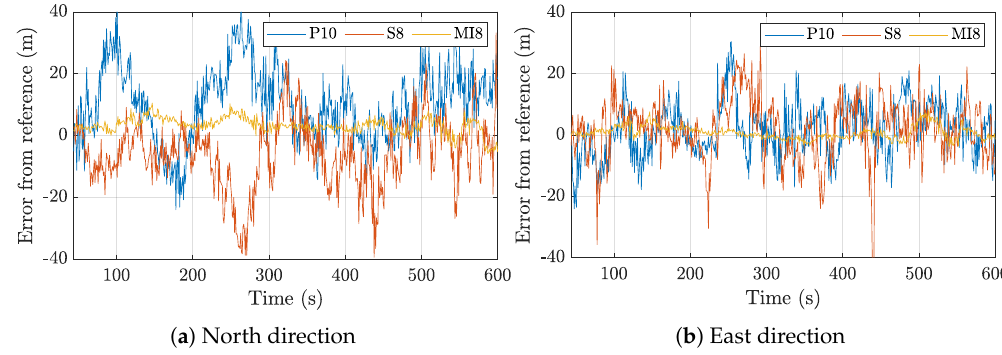
Figure 4. North ( a ) and East ( b ) position errors with respect to the reference position for all the three smartphones under the test in a real environment.